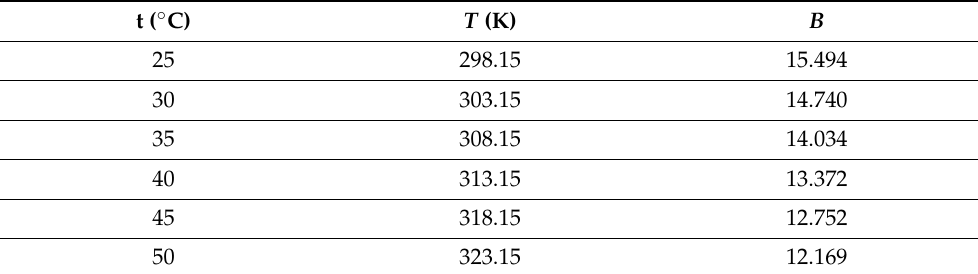
Table 9. Changes of value B as function of temperature.